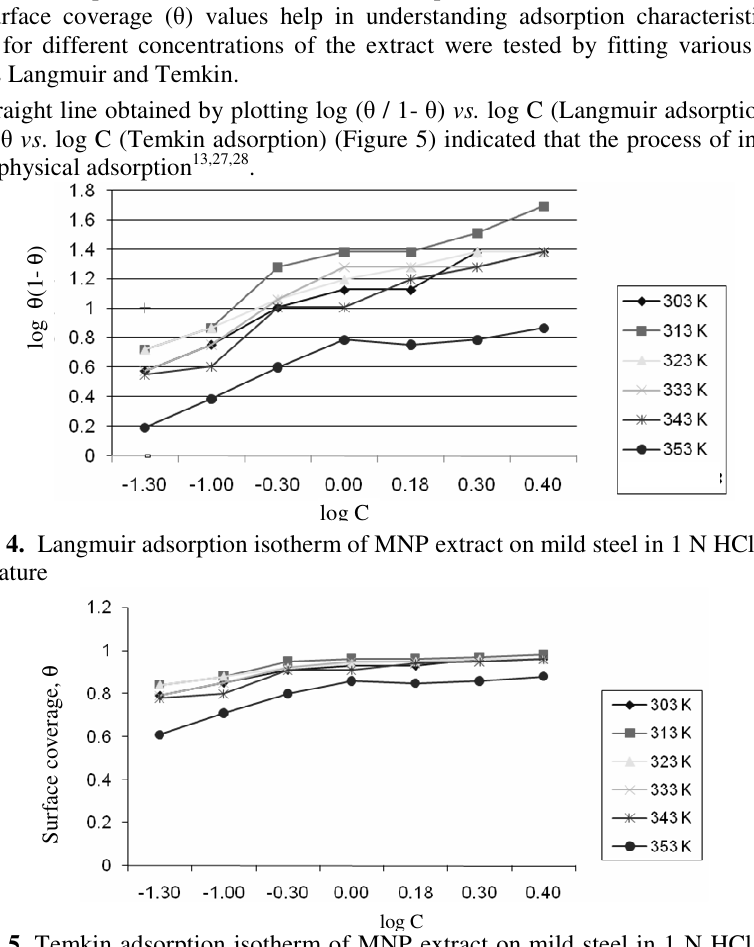
Figure 5. Temkin adsorption isotherm of MNP extract on mild steel in 1 N HCl at